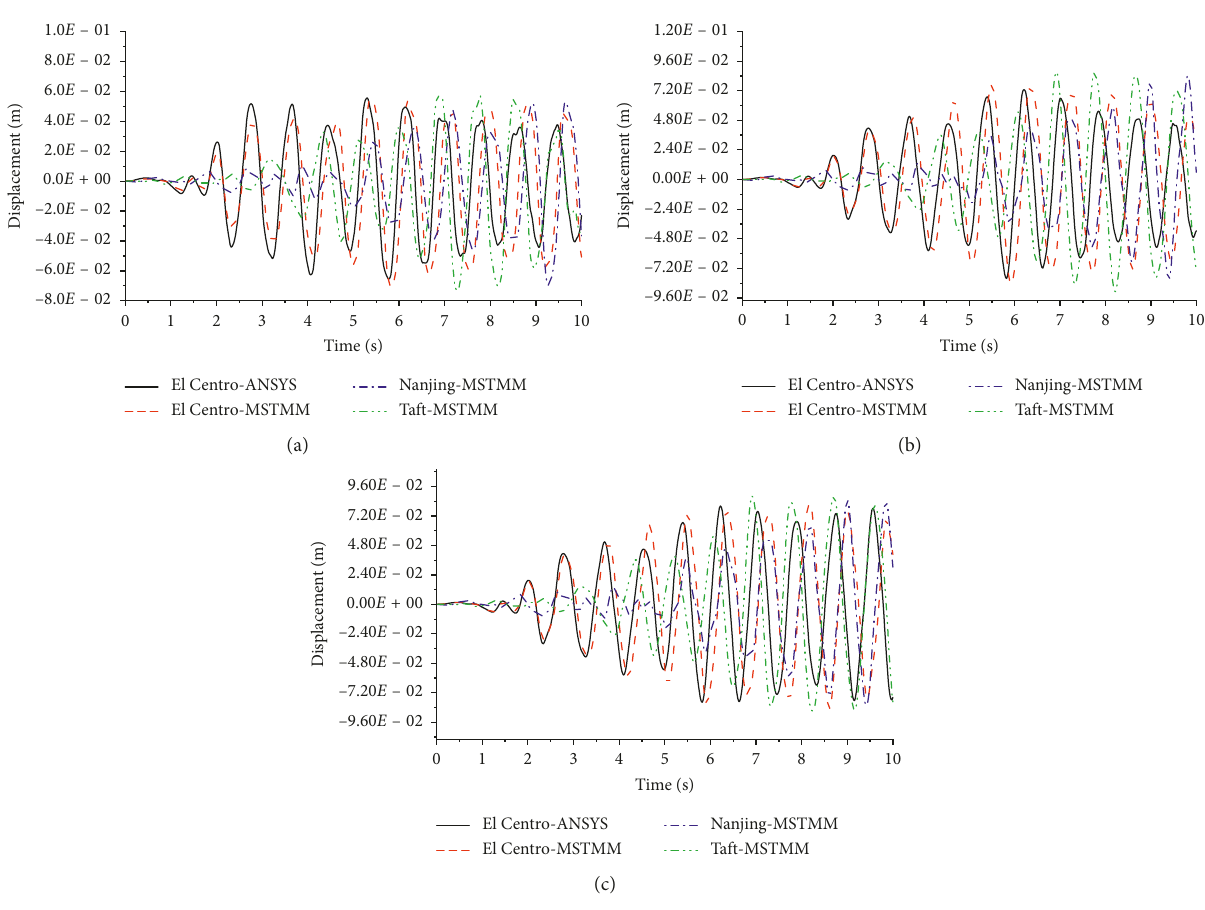
Figure 20: Time-history diagram of J